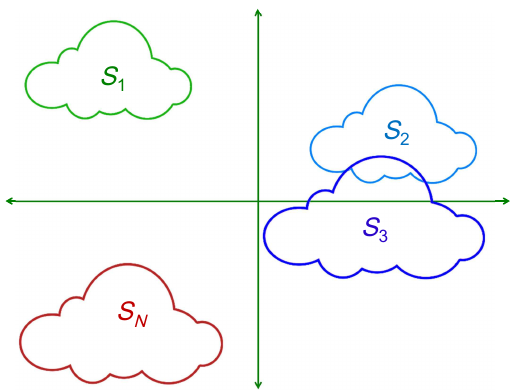
Fig. 4 Representation of the sentiment space in a 2-dimensional